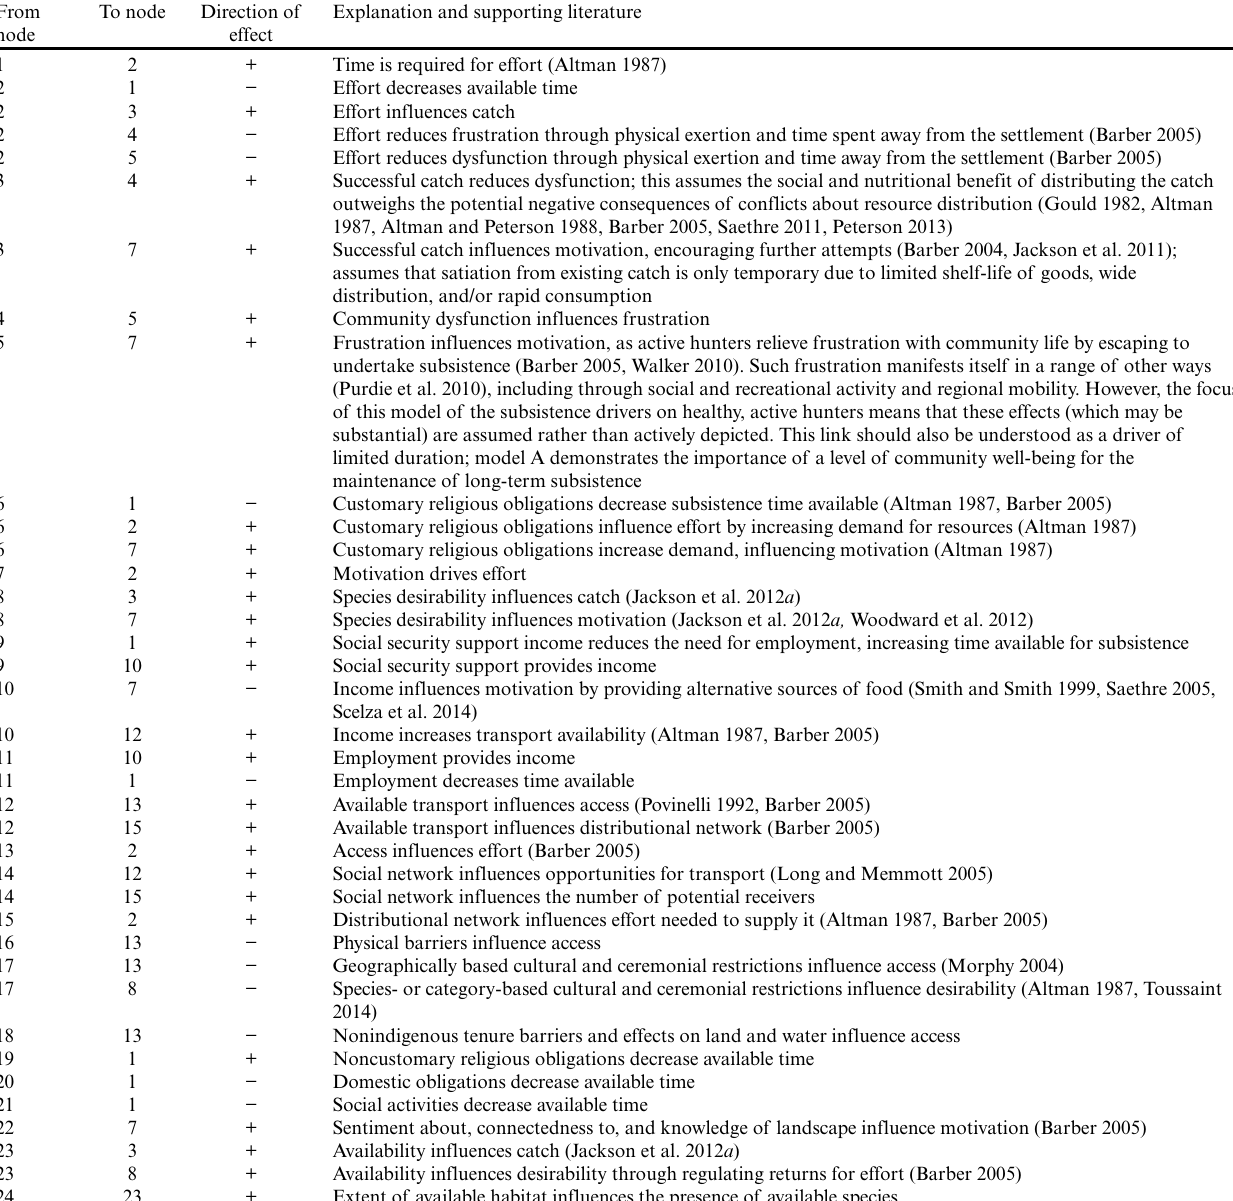
Table 4. Definition and explanation of links in model B. From